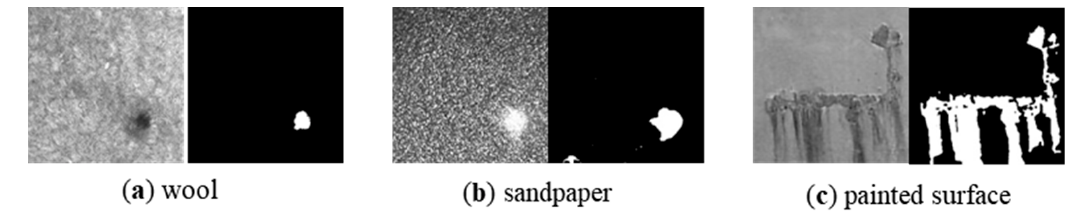
Figure 15. Statistical-texture defect of detection results.